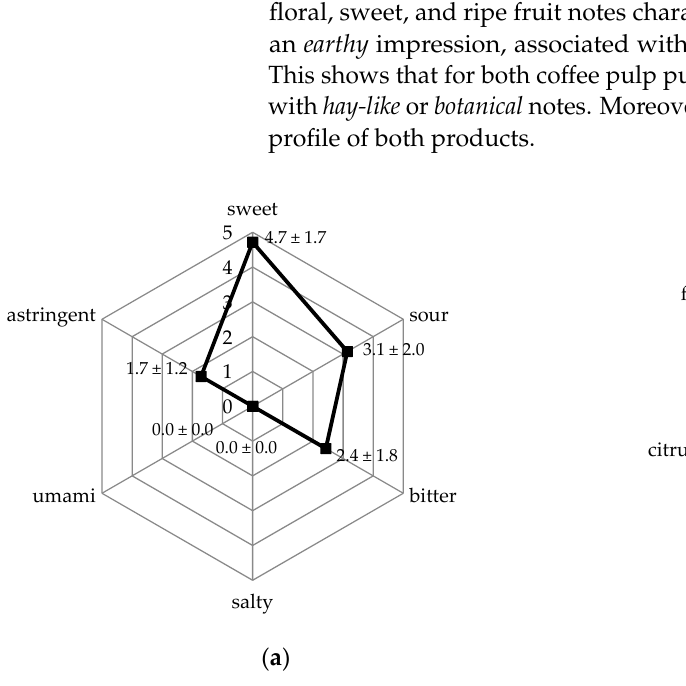
Figure 2. Taste profile ( a ) and aroma profile ( b ) of a processed Robusta coffee pulp puree, perceived via retronasal evaluation. Note that the intensity scale has been adjusted to cover the range of rated intensities (maximum rated intensity of 4.7), rather than the full range available (10).